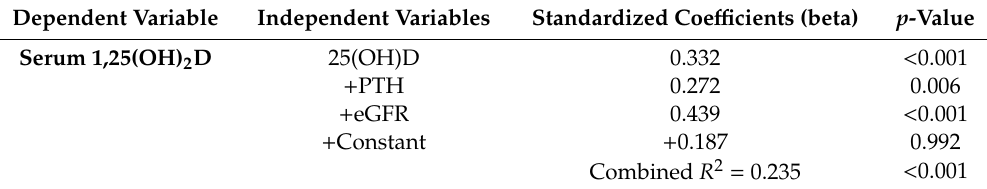
Table 2. Determinants of serum 1,25(OH) 2 D- Multiple linear regression analyses.